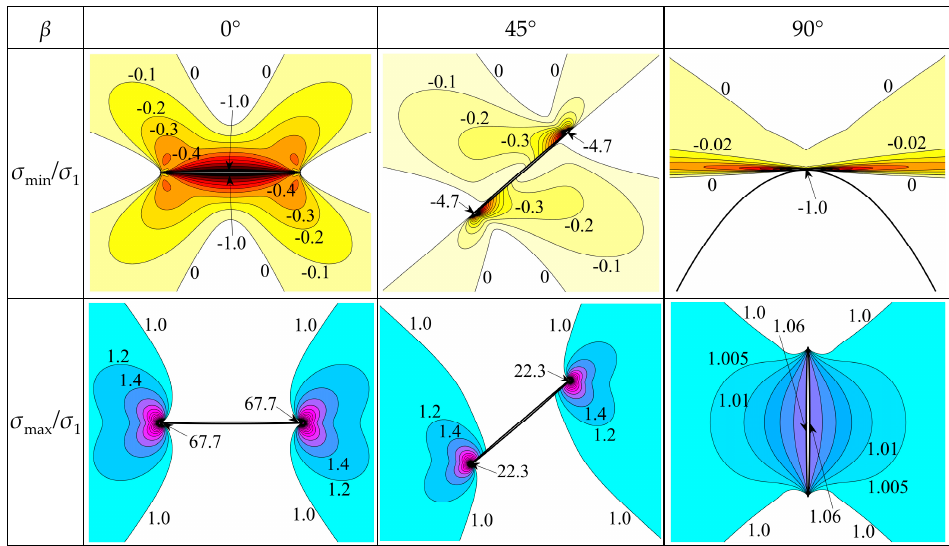
Figure 22. The distribution of σ min / σ 1 and σ max / σ 1 around an elliptic crack with the axial ratio b / a = 0.03 and β = 0°, 45° and 90° in an infinite elastic solid subject to a far-field uniaxial compression stress σ 1 . hole and the joints will be affected by their interaction. At the early elastic stage when σ 1 = 1 MPa, Figures 23 and 24 show the distribution of hoop stress σ θ and hoop stress concentration factor ( σ θ / σ 1 ) along the hole periphery in the specimens with k = 0.2 and 0.8 at β = 0°, 45°, and 90°, respectively.